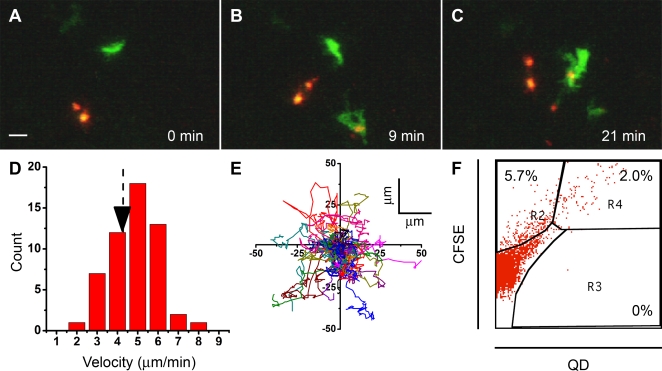
QD-labeled DCs visualized in situ in murine lymph nodes.(A–C) Sequential two-photon images of in situ-labeled DCs inside draining lymph nodes 24 hr after subcutaneous injection of CFSE (green) and QD (red) included in CFA. The time elapsed (min) after beginning imaging is indicated. The images were taken from Video S8. Scale bar = 20 µm. (D) Velocity distribution of DCs in lymph nodes. Arrow indicates average velocity (4.3±1.2 µm/min). (E) Trajectories of DCs in lymph nodes, normalized to their starting coordinates. (F) Profiles of CFSE+ and QD+ cells in draining lymph. Percentage of cells (except double negatives) have been indicated on the figure.